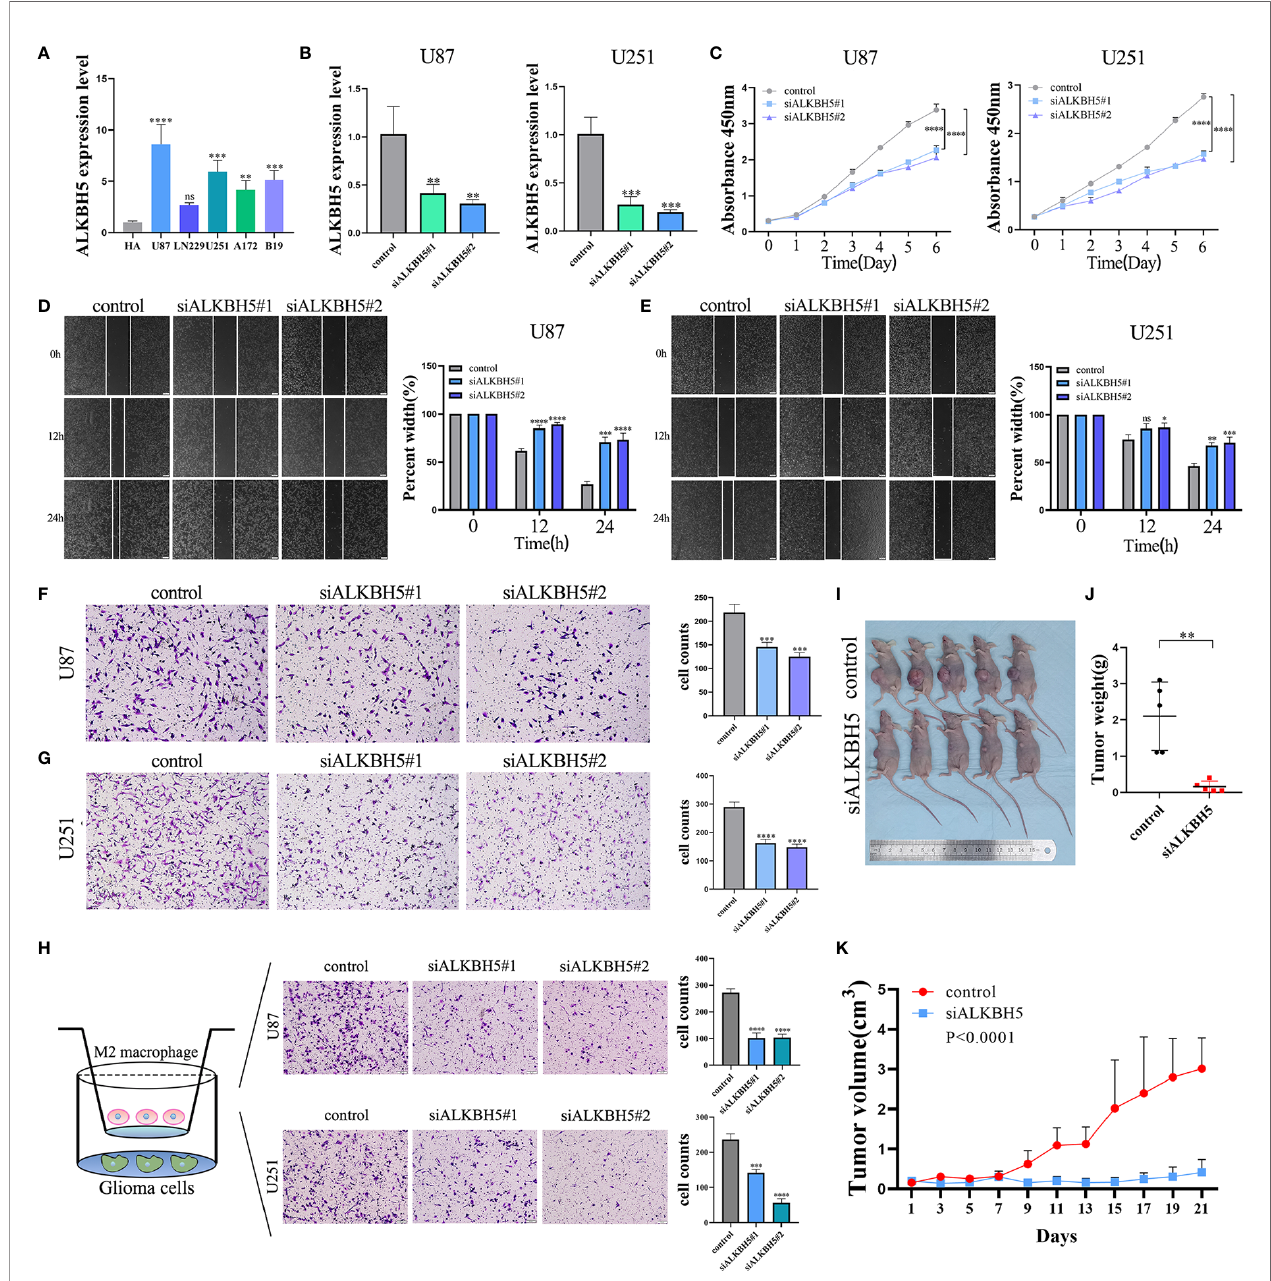
FIGURE 9 | The biological functions of ALKBH5 in glioma. (A) The expression levels of ALKBH5 were veri fi ed in multi-cell lines, including human astrocyte (HA), U87, LN229, U251, A172 and B19 cell lines. (B) Veri fi cation of knockdown ef fi ciency of ALKBH5 in U87 and U251 cell lines. The biological functions of ALKBH5 on glioma cell lines were veri fi ed by CCK-8 (C) , wound healing (D, E) and Transwell (F, G) experiments. Xenograft mouse models were generated by subcutaneous injection of U87 cells into nude mice. Seven days after implanted, mice were treated with control siRNA (n=8) or ALKBH5 siRNA (n=8). (H) In fi ltration of M2 macrophage in control (left), siALKBH5#1 (middle), siALKBH5#2 (right) of U87 and U251 cells. Representative image of subcutaneous tumors (I) , tumor weight (J) and tumor growth curve (K) , in si-ALKBH5 treated or control siRNA treated xenograft models with U87 cells. ns (nonsense), * P <0.05, ** P <0.01, *** P <0.001, **** P